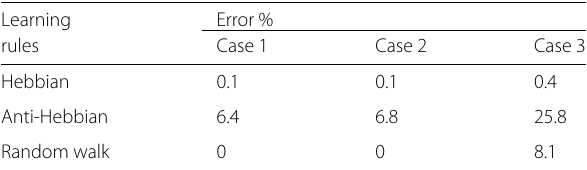
Table 1 TPM synchronization